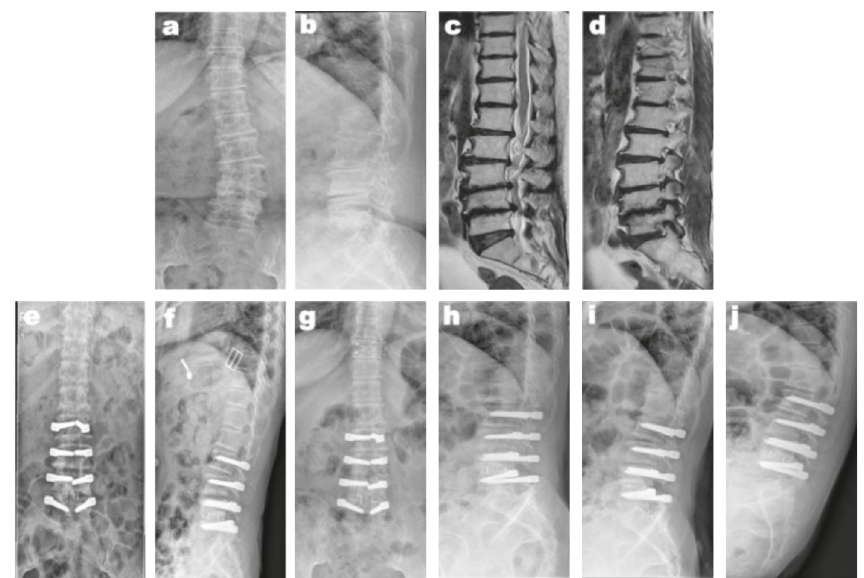
Figure 2: A 49-year-old woman had vertebral canal stenosis at L2–5 and left lateral recess stenosis at L4-5 with DLS (a–d). She underwent fenestration decompression at L3-4, TLIF at L4-5, and instrumentation at L2–5 using the Dynesys system. Postoperative radiographs showed scoliosis correction (e, f), the radiographs obtained 42 months after the operation showed motion preservation and no progression of scoliosis